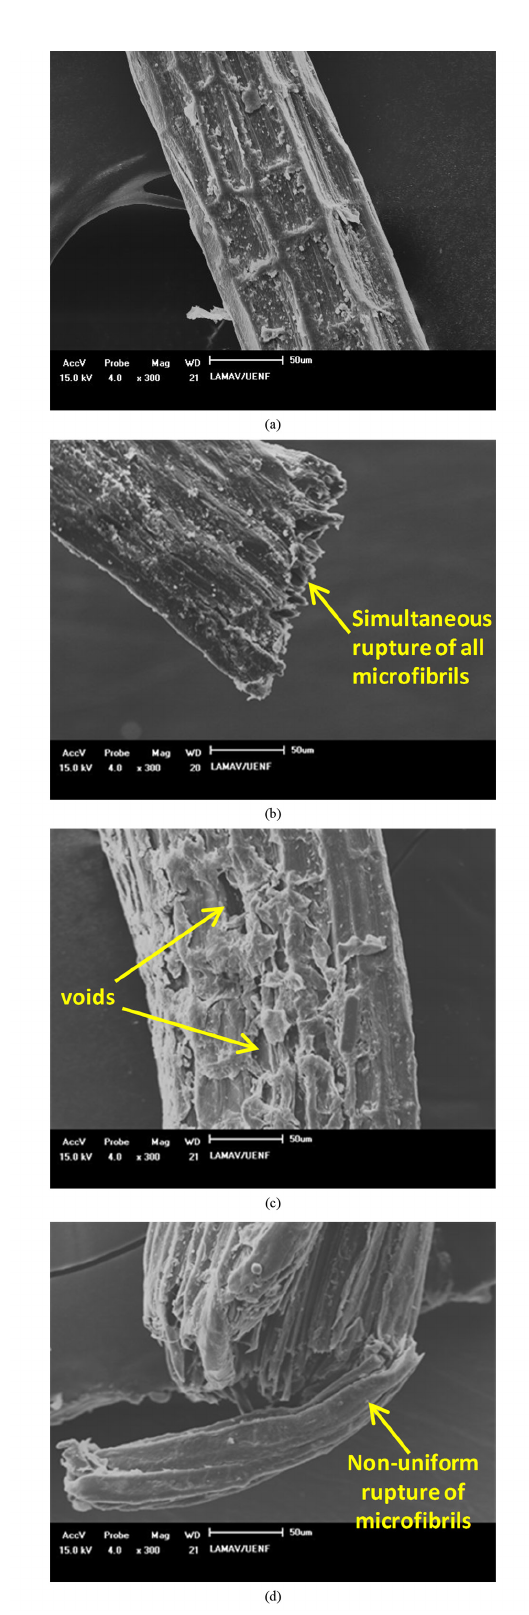
Figure 7. SEM micrographs for: (a) and (b) thinner fiber as well as (c) and (d) thicker fiber. Source: authors.